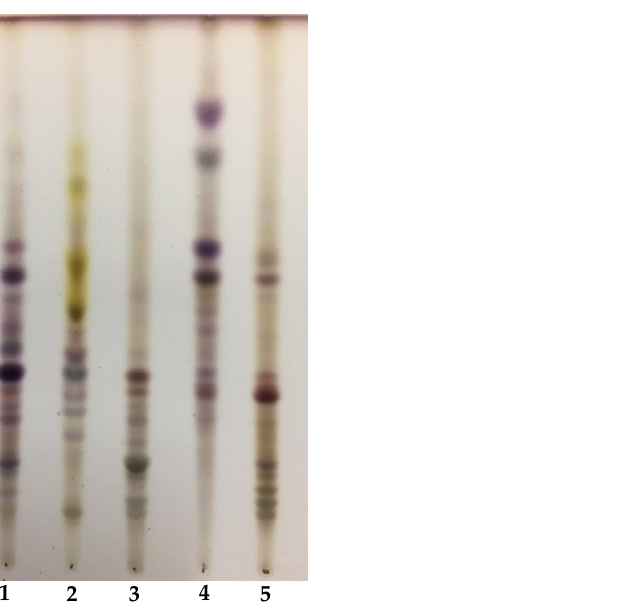
Figure 1. TLC of the five saponin extracts. 1: M. heyniana ; 2: M. hybrida ; 3: M. lupulina ; 4: M. murex ; 5: M. truncatula . Spots were visualized by Liebermann–Burckard reagent. Table 2. Sapogenin composition (expressed as % ± SD of total sapogenins) obtained by acid hydrolysis of saponins extracted by the five Medicago spp.